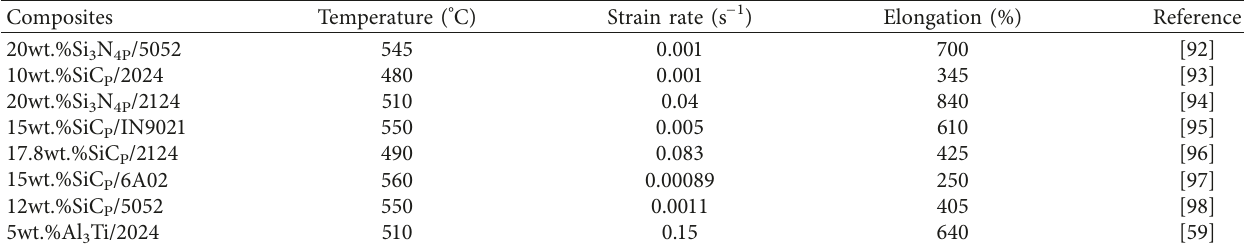
Table 4: Deformation conditions of optimal superplastic elongation of aluminum matrix